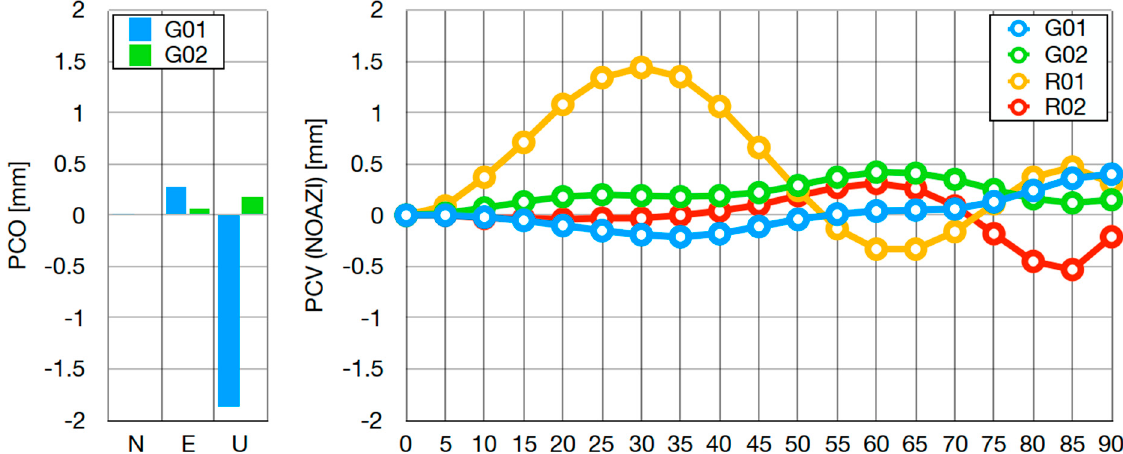
Figure 3. PCO and PCV difference between I08.ATX and I14.ATX calibration data for the TRM57971.00 NONE antenna.